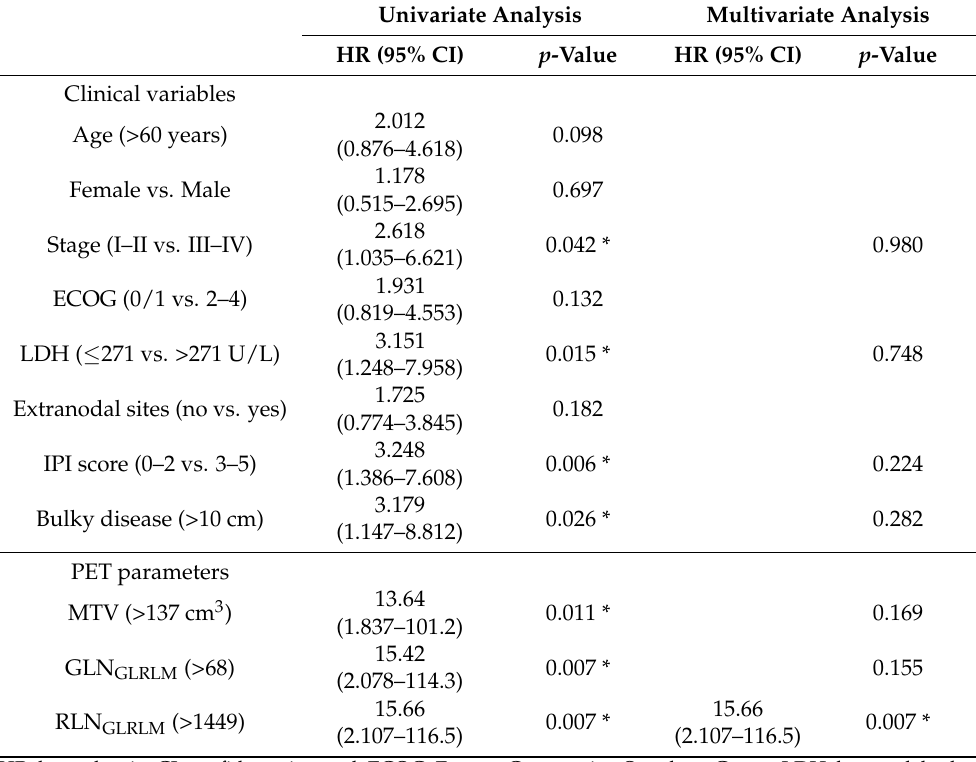
Table 2. Univariate and Multivariate Analyses for Prognostic Factors of Progression-free Survival. Univariate Analysis Multivariate